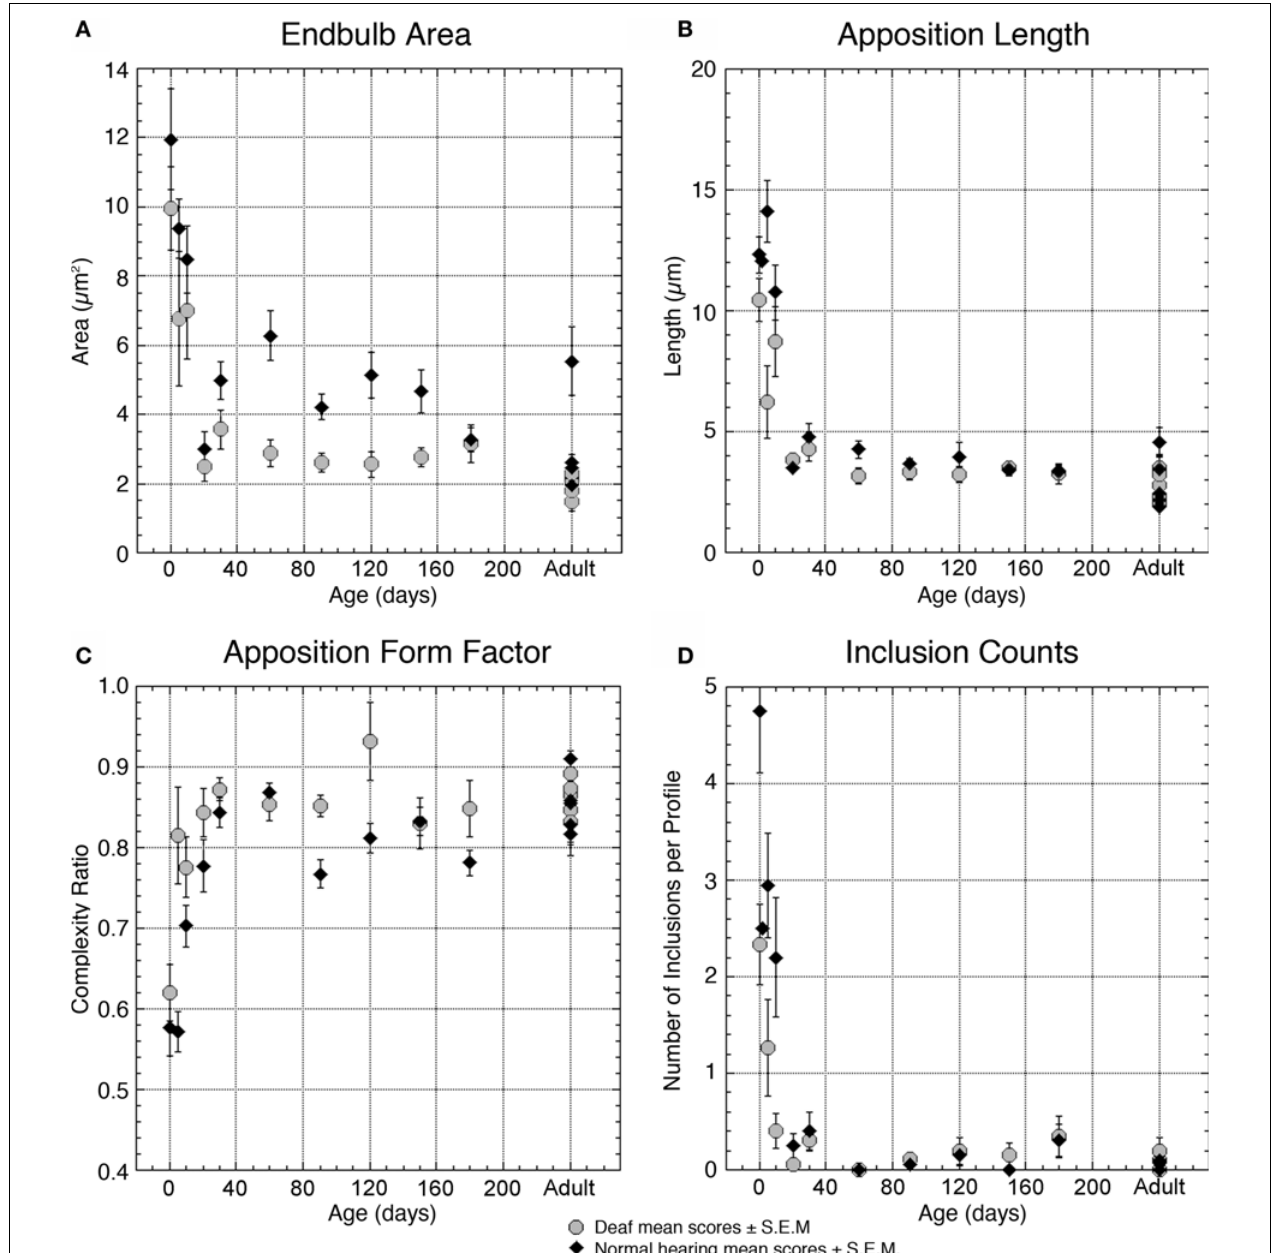
to the contour length of the apposition provides a measure of contact complexity. This ratio approaches one as the membrane between the endbulb and SBC fl attens. Endbulb appositions of deaf cats are in general less curvy than those of normal cats before 30 days of age. (D) Somatic inclusions are common in young animals but disappear by 20–30 days. Deaf animals have fewer than half the number of inclusions present in normal animals at early ages. Each point represents an average of multiple measures collected from two animals at all time points except adult, where each point represents the average for one animal. Data values from normal hearing cats are replotted from Ryugo et al.